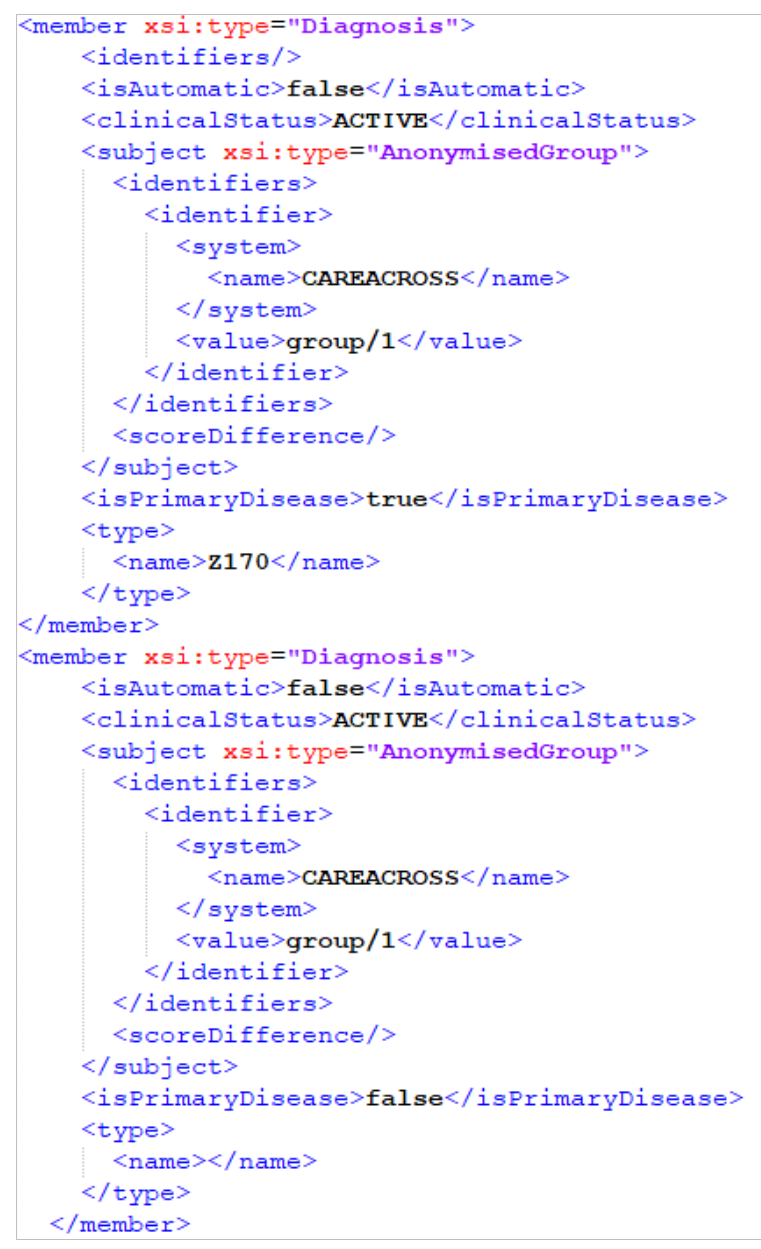
Figure 6. Output of CareAcross data from the Data Conversion